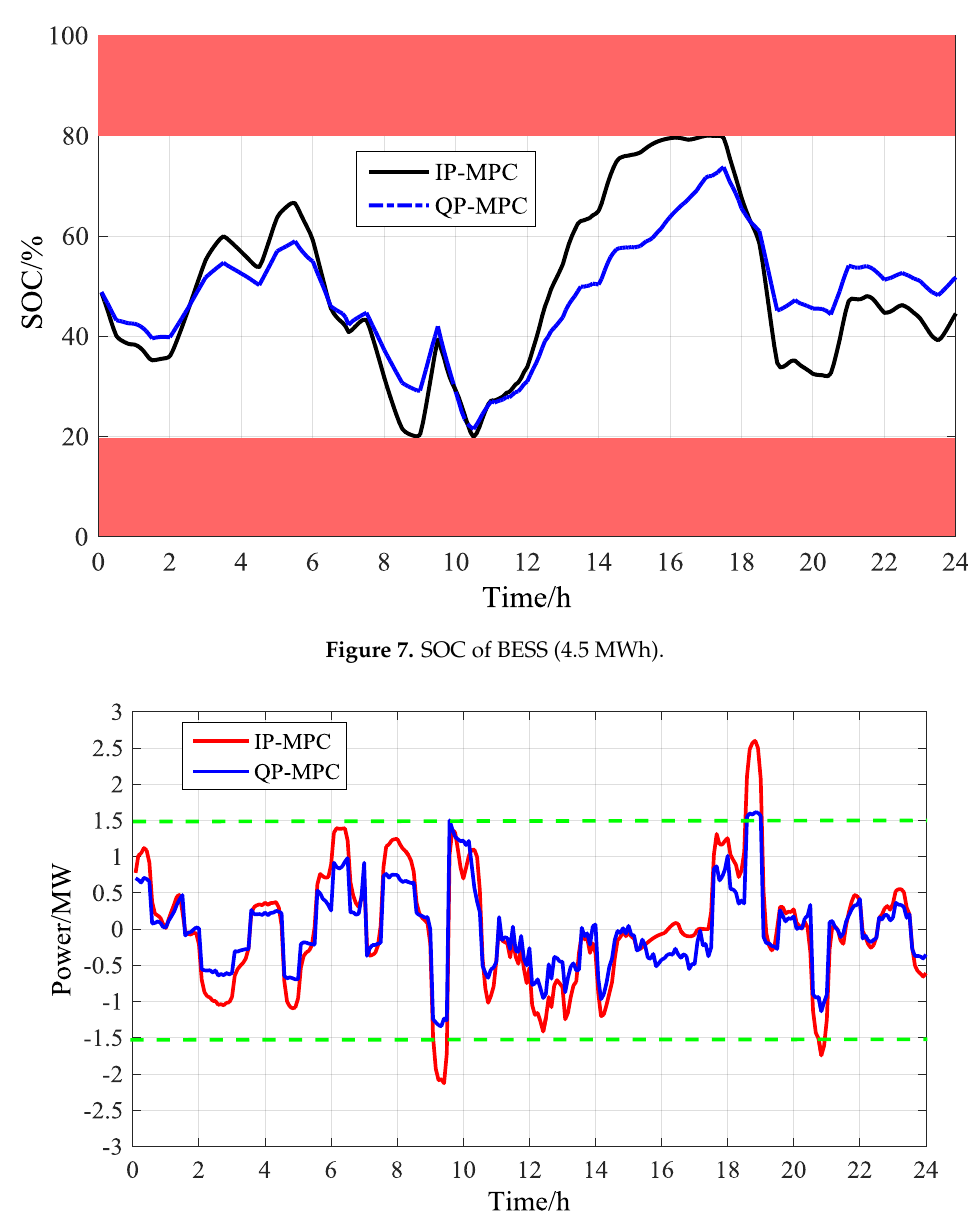
Figure 8. Power response of BESS (4.5 MWh).